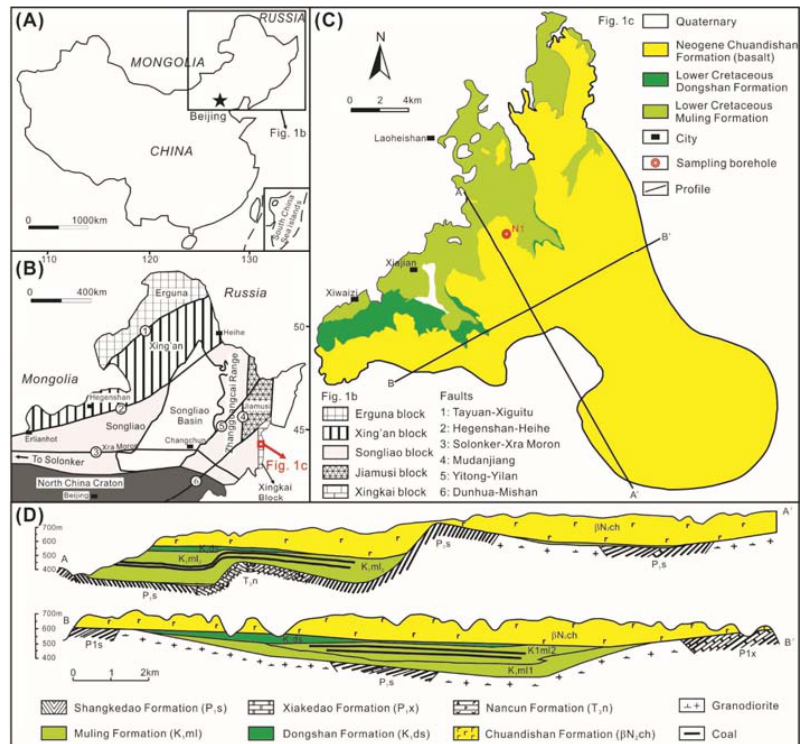
Figure 1. ( A ) Schematic map of NE China. ( B ) Simplified geological map of NE China, illustrating the location of the Laoheishan Basin. ( C ) Geological map of the Laoheishan Basin and the sampling well. ( D ) Cross profiles of the Laoheishan Basin [28].